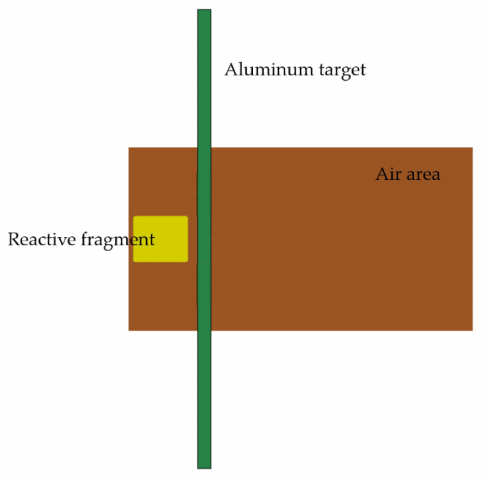
Figure 4. Simulation model of impact energy release of PTFE/Al reactive fragment.